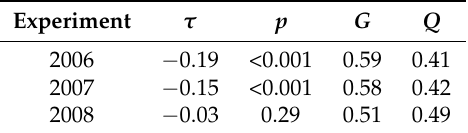
Table 2. Estimates of Kendall’s correlation coefficient τ , its significance level p , probabilities of multidirectional G and unidirectional Q changes of V (cid:48) and P s in the tectonic component of the relation. Experiment τ p G Q 2006 −